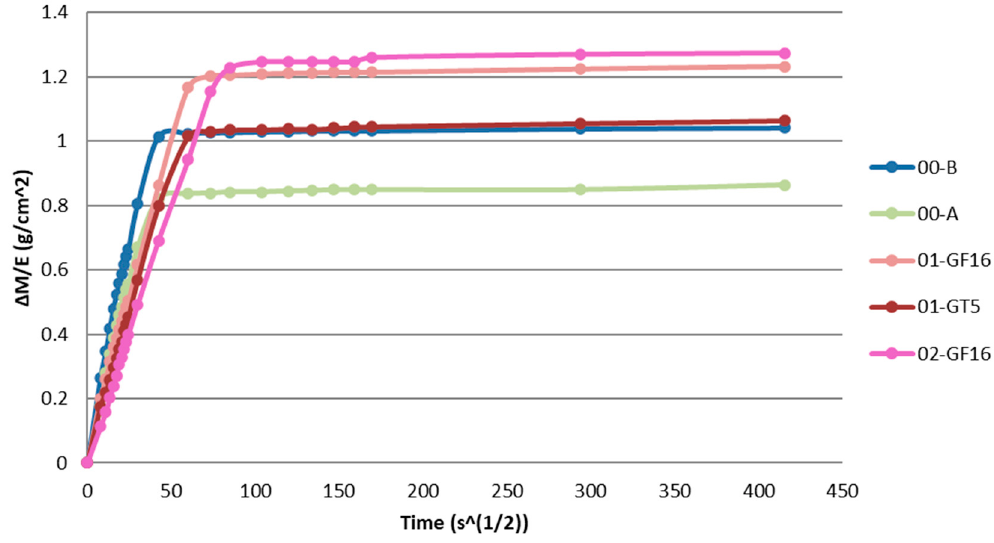
Figure 11. Capillarity water absorption curve. Table 9. Average capillarity water absorption coefficient